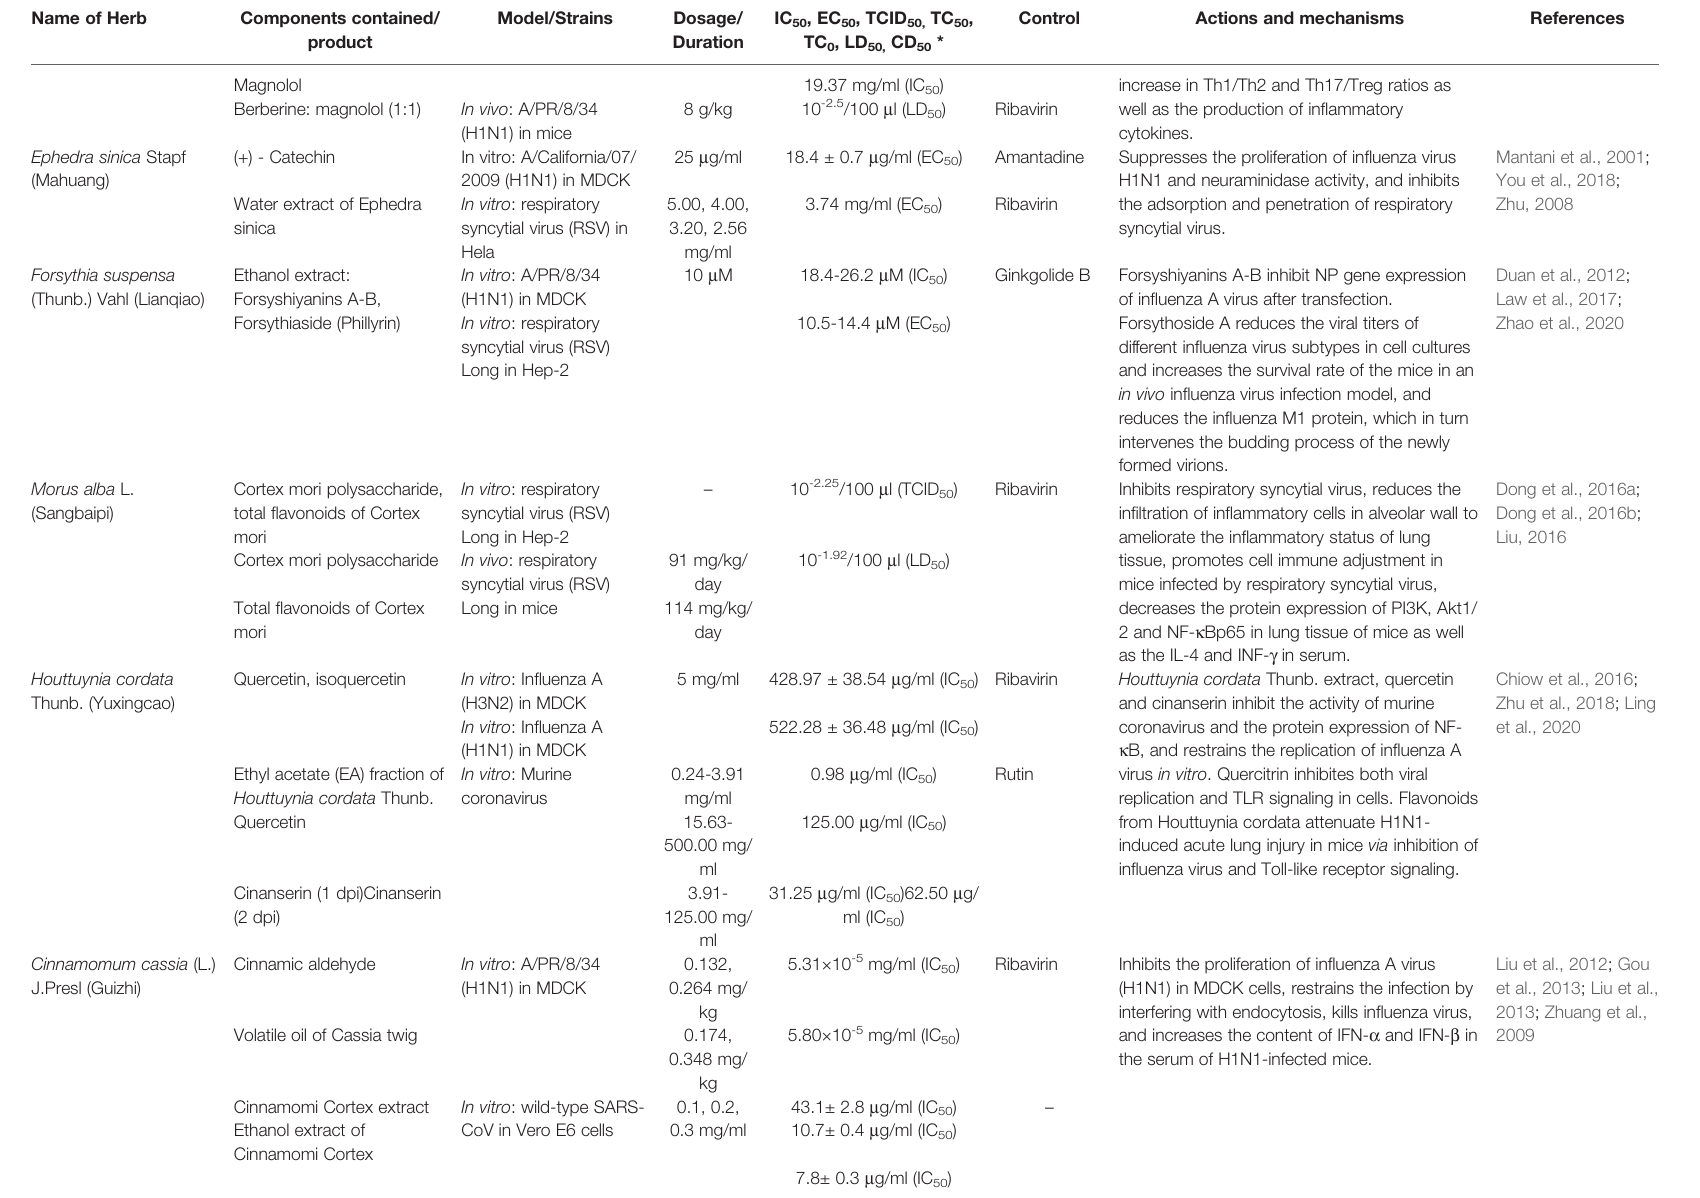
interfering with endocytosis, kills in fl uenza virus, and increases the content of IFN- a and IFN- b in the serum of H1N1-infected